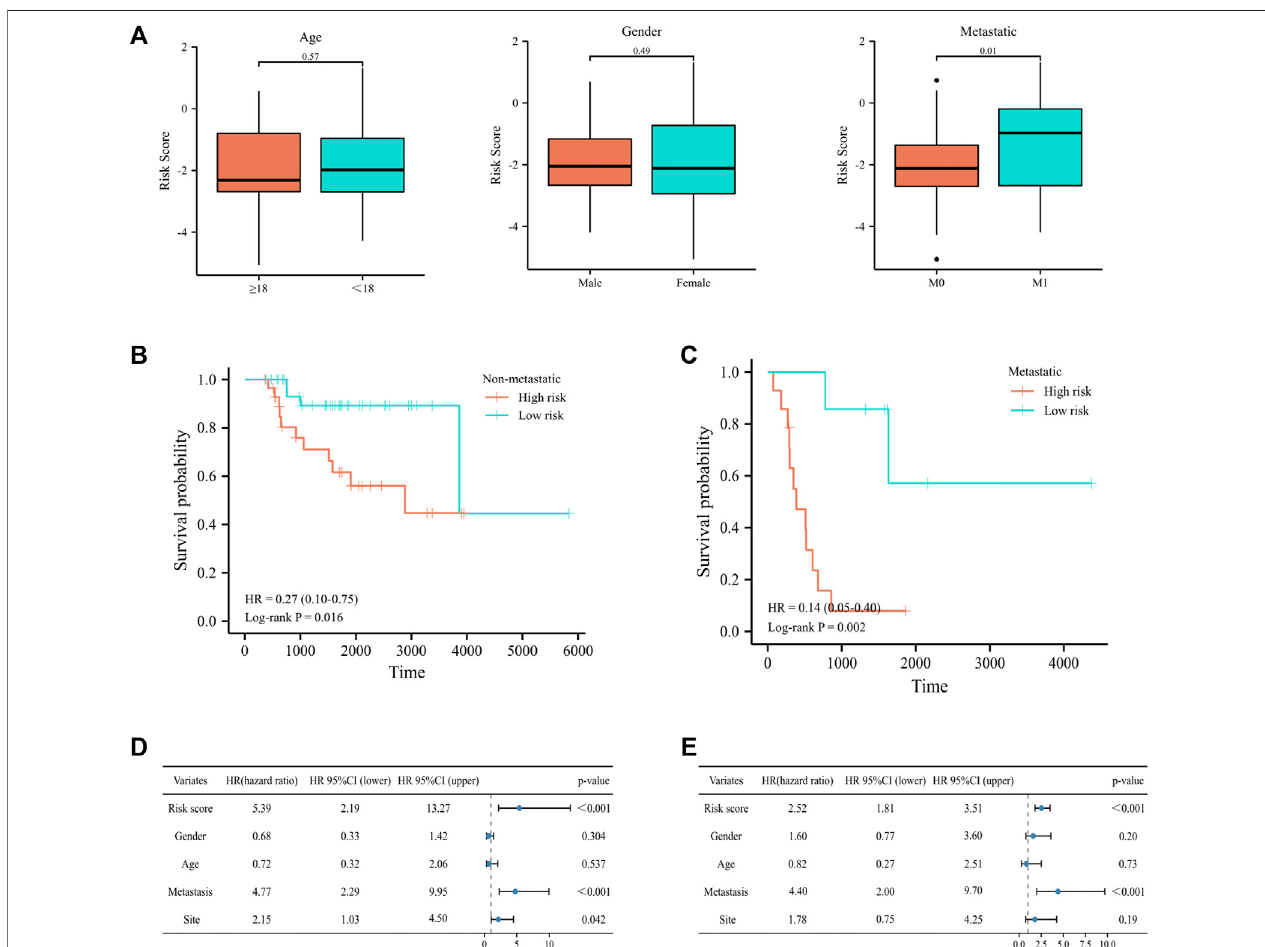
FIGURE5| Correlationoftherisksignaturewithclinicalfeaturesinthetrainingcohort. (A) Differencesinriskscoresamongosteosarcomapatientsbyage,gender, and metastatic status. (B – C) Survival curves for patients with osteosarcoma regrouped by metastatic status. (D – E) Univariate and multivariate cox regression analyses for integrating risk characteristics and clinical